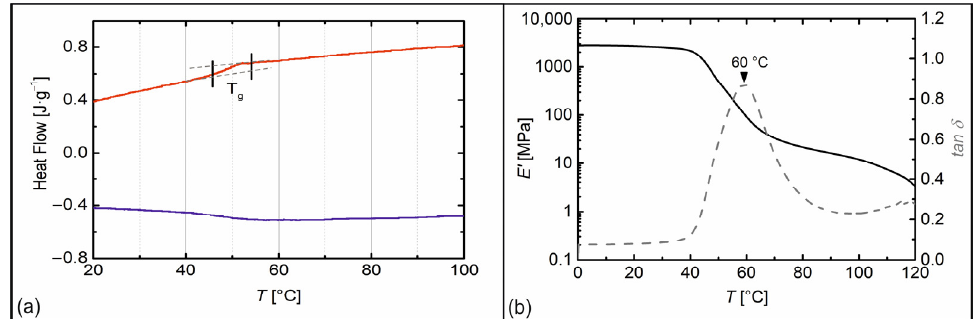
Figure 1. Thermal and thermomechanical properties of PPG-based TPU as determined by DSC ( a ); second heating (red) and cooling (purple) at heating and cooling rates of 10 °C·min − 1 ) and DMA ( b ); temperature dependence of storage modulus E ′ (solid line) and tan δ (dashed line) at a heating rate of 3 °C·min − 1 ).